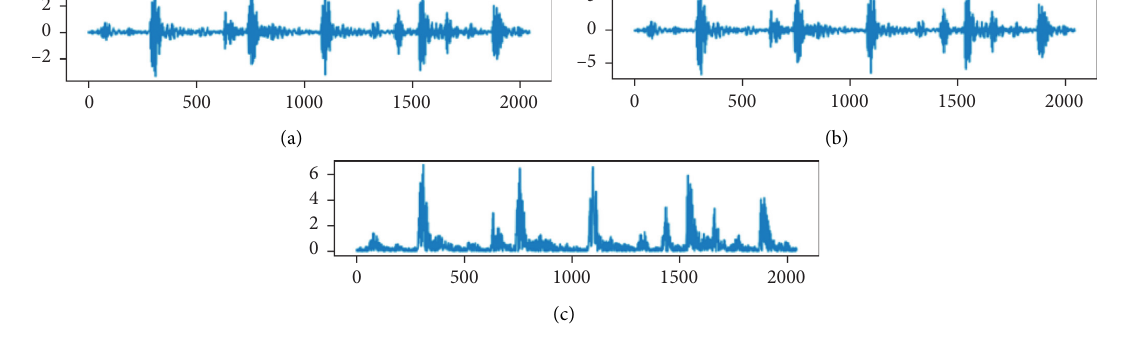
Figure 14: 0.021-inch OR fault. Table 2: Training set and test